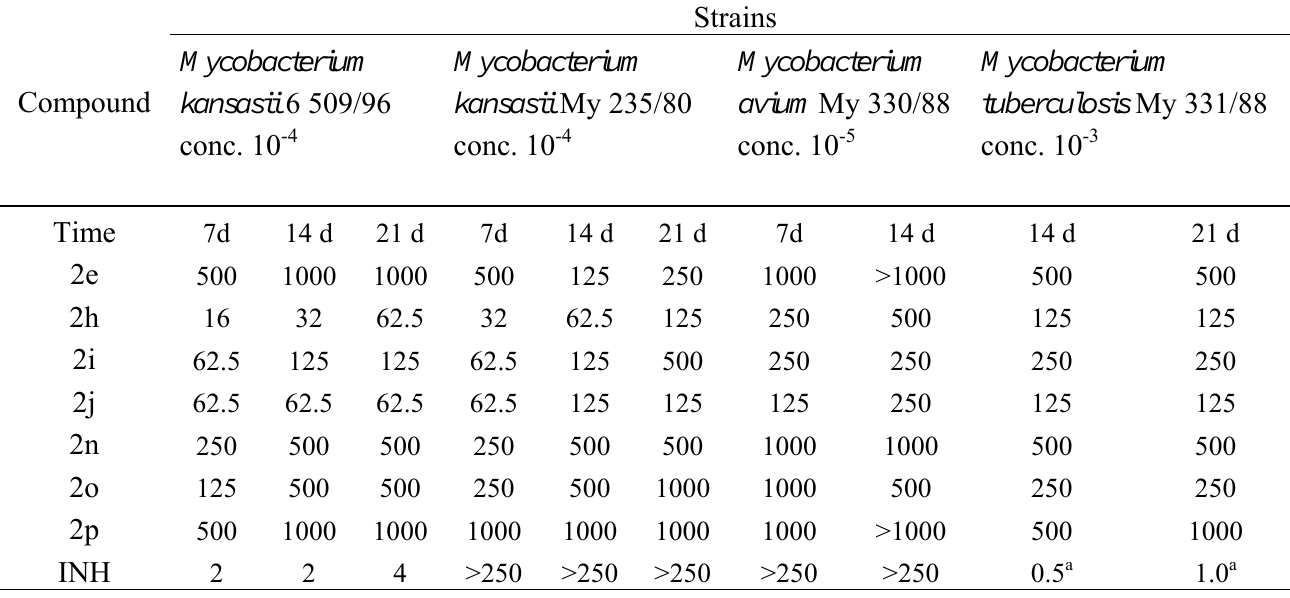
Table 1. In vitro antimycobacterial activity of compounds expressed as MIC ( µ mol·L -1